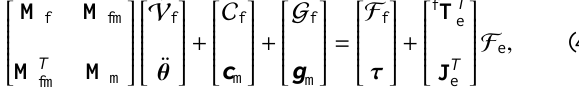
tial seven-DOF model, with active ( θ 1 through θ 5 ) and passive ( θ 6